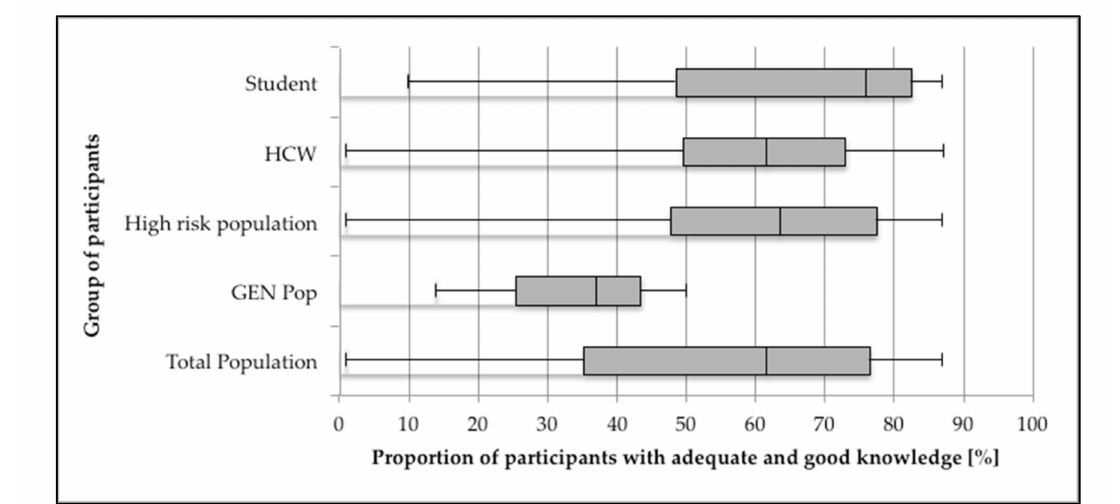
Figure 2. Proportion of participants with good and adequate knowledge combined.